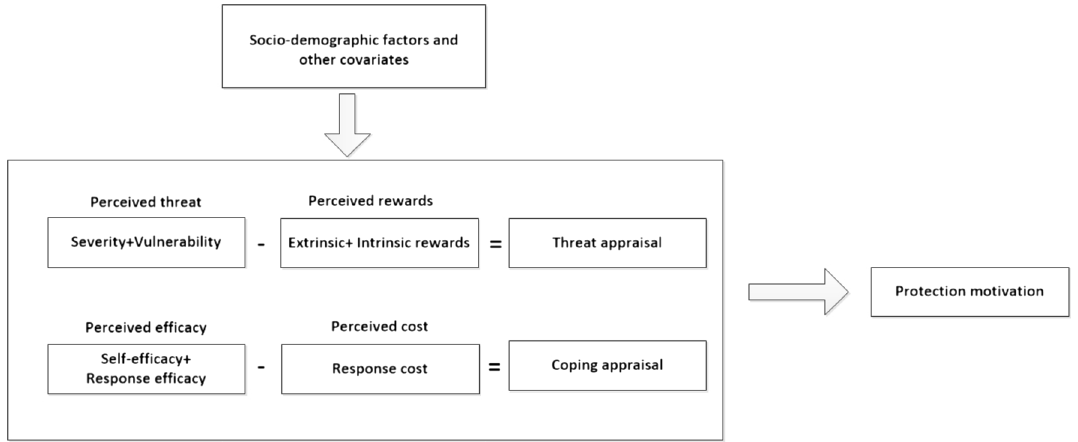
Figure 1. Protection motivation theory